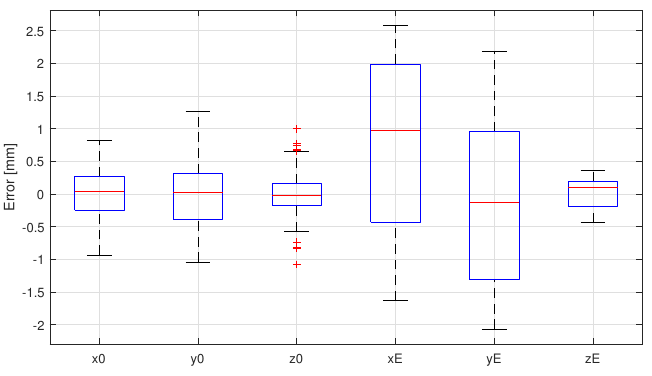
Figure 11. Errors for the identified values based on simulation